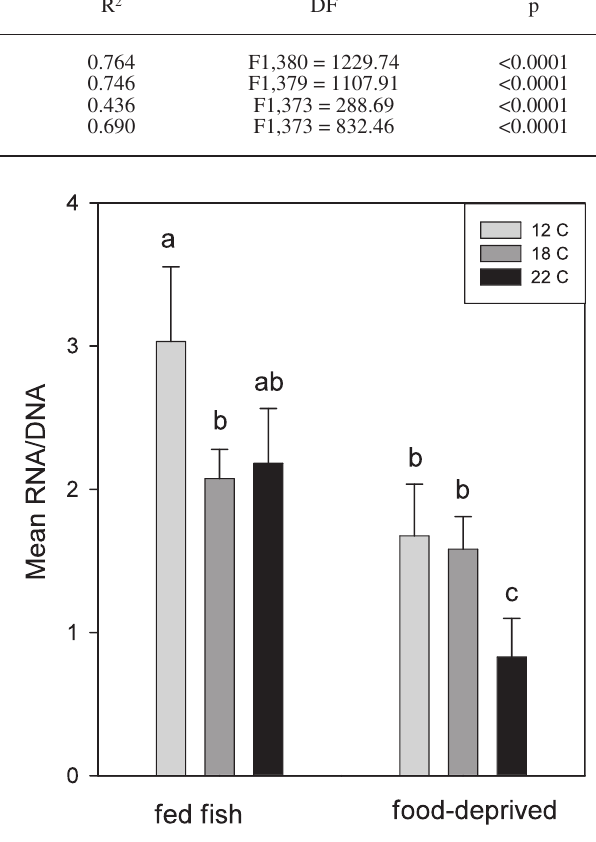
F IG . 2. – Mean RNA/DNA with standard deviation of fed and food- deprived fish at 3 different temperatures after 7 days. Letters denote significant differences as determined by